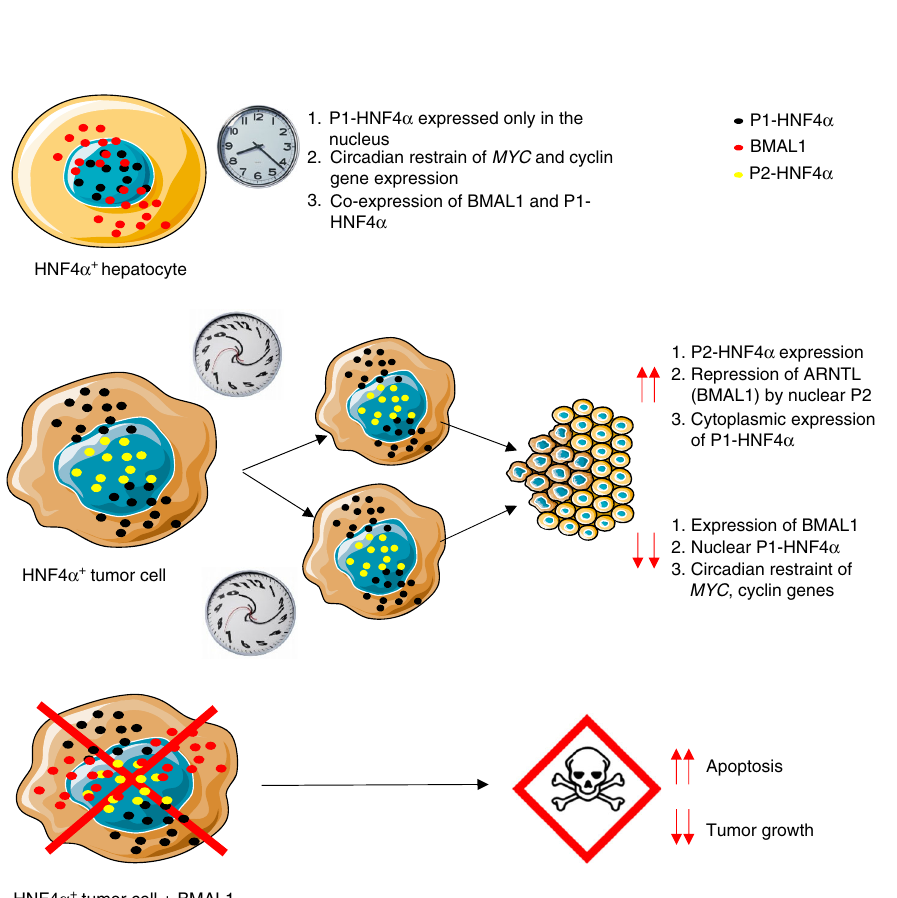
Fig. 7 Model of HNF4 α isoform and BMAL1 expression in normal vs. cancer cells. In normal hepatocytes, the P1-HNF4 α isoform and the circadian protein